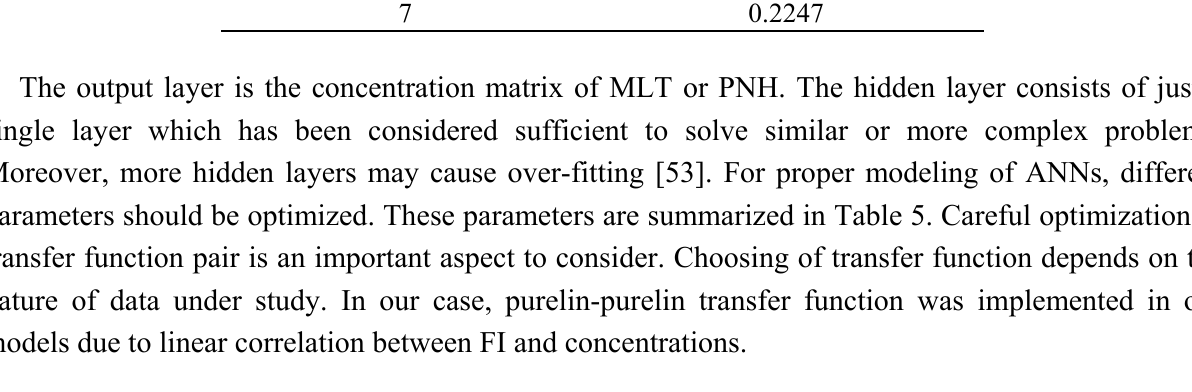
Table 5. Optimized parameters of